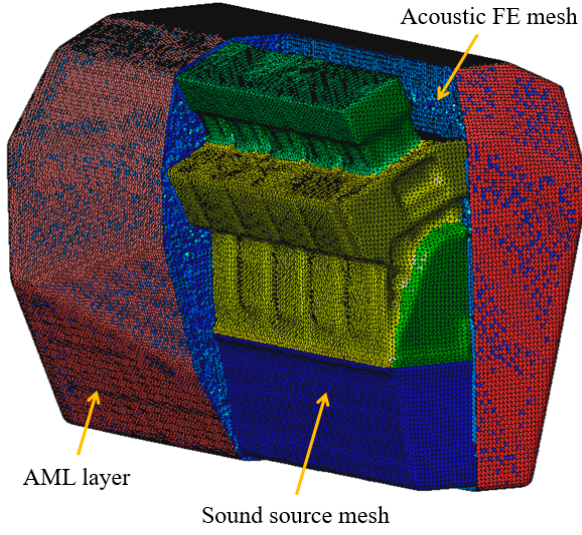
Figure 8. Acoustic calculation model.